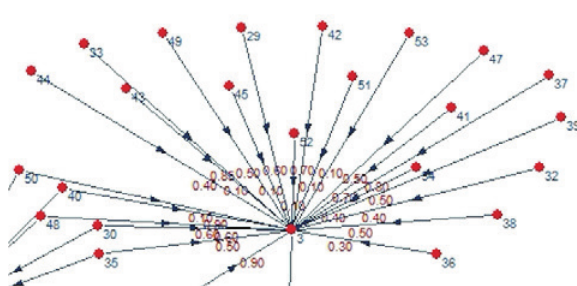
Figure 5. Analysis of the levels of